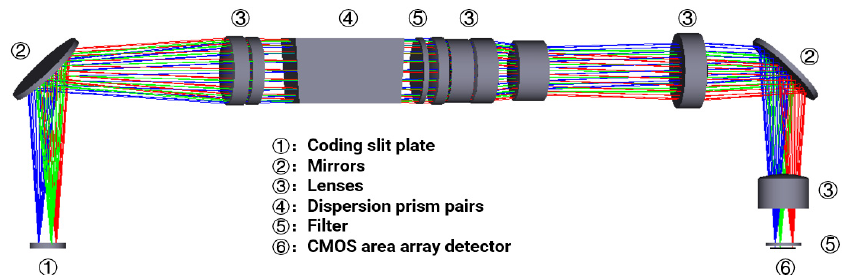
Figure 4. Optical layout of the system.